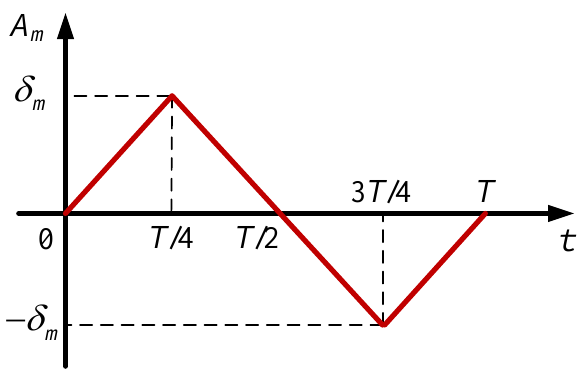
Figure 3. Exciting signal of the telescoping rod.